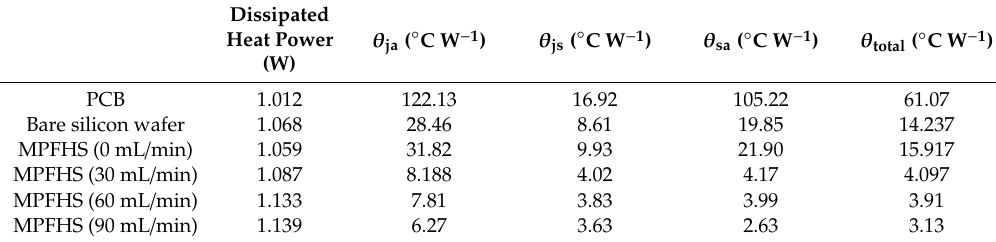
Table 3. Thermal resistance calculated from experimental data at the same power